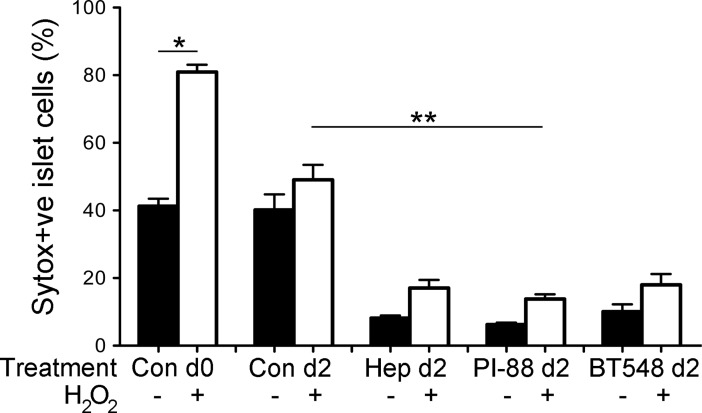
HS mimetics protect human beta cells from oxidative damage.Flow cytometric analyses of isolated human islet cells cultured with or without HS mimetics for 2 days and then treated acutely with hydrogen peroxide. Islet cell death/damage was measured by Sytox green fluorescence. Con, control; Hep, Heparin; BT548, chemically modified LMWH. Data shows mean ± SEM; n = 11–12 independent experiments. Con d0 versus Con d0 + hydrogen peroxide, Unpaired t-test, *P<0.0001; Con d2 + hydrogen peroxide versus PI-88 d2 + hydrogen peroxide, non-parametric ANOVA with Dunn’s Multiple Comparisons test, ** P<0.05.